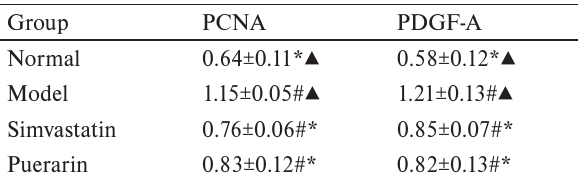
Table 5. Aortic PCNA and PDGF-A protein expression levels.